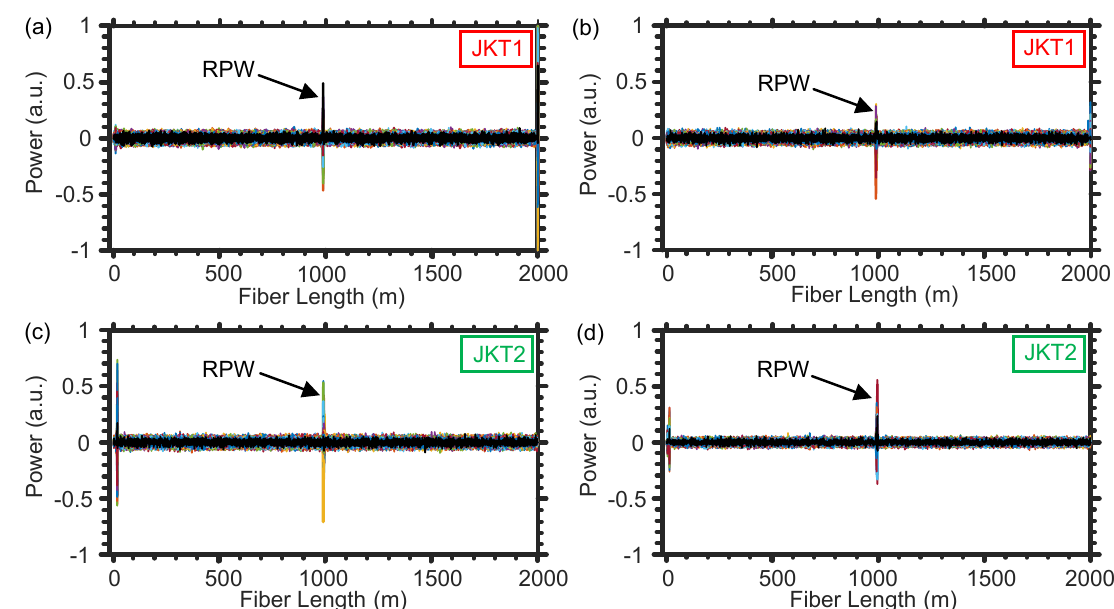
Figure 5. Representative examples of the infested tree’s position information when using the SMF of JKT1 ( a , b ) and JKT2 ( c , d ).